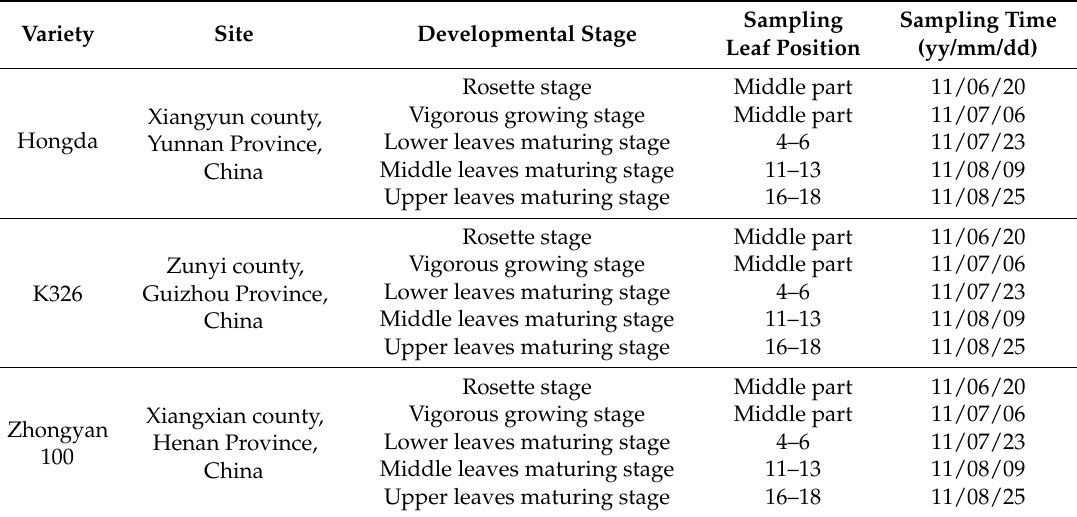
Table 1. The information about plant material